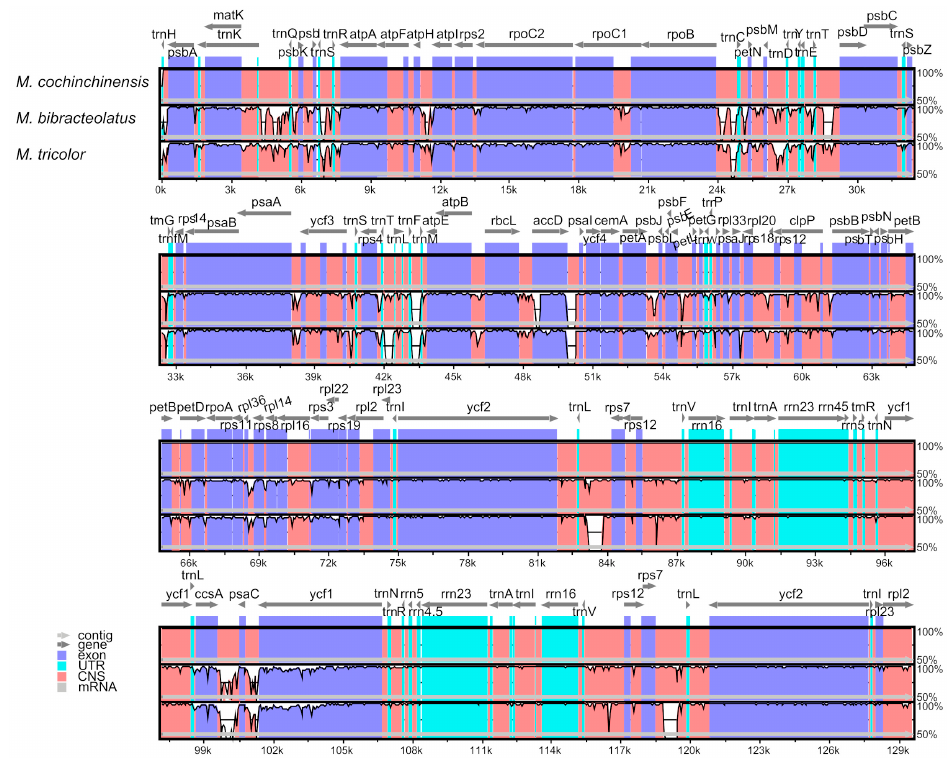
Figure 6. Sequence identity plot comparing the three chloroplast genomes with M. cochinchinensis as a reference by using mVISTA. Grey arrows and thick black lines above the alignment indicate genes with their orientation and the position of their IRs, respectively. A cut-off of 70% identity was used for the plots, and the Y-scale represents the percent identity ranging from 50% to 100%.